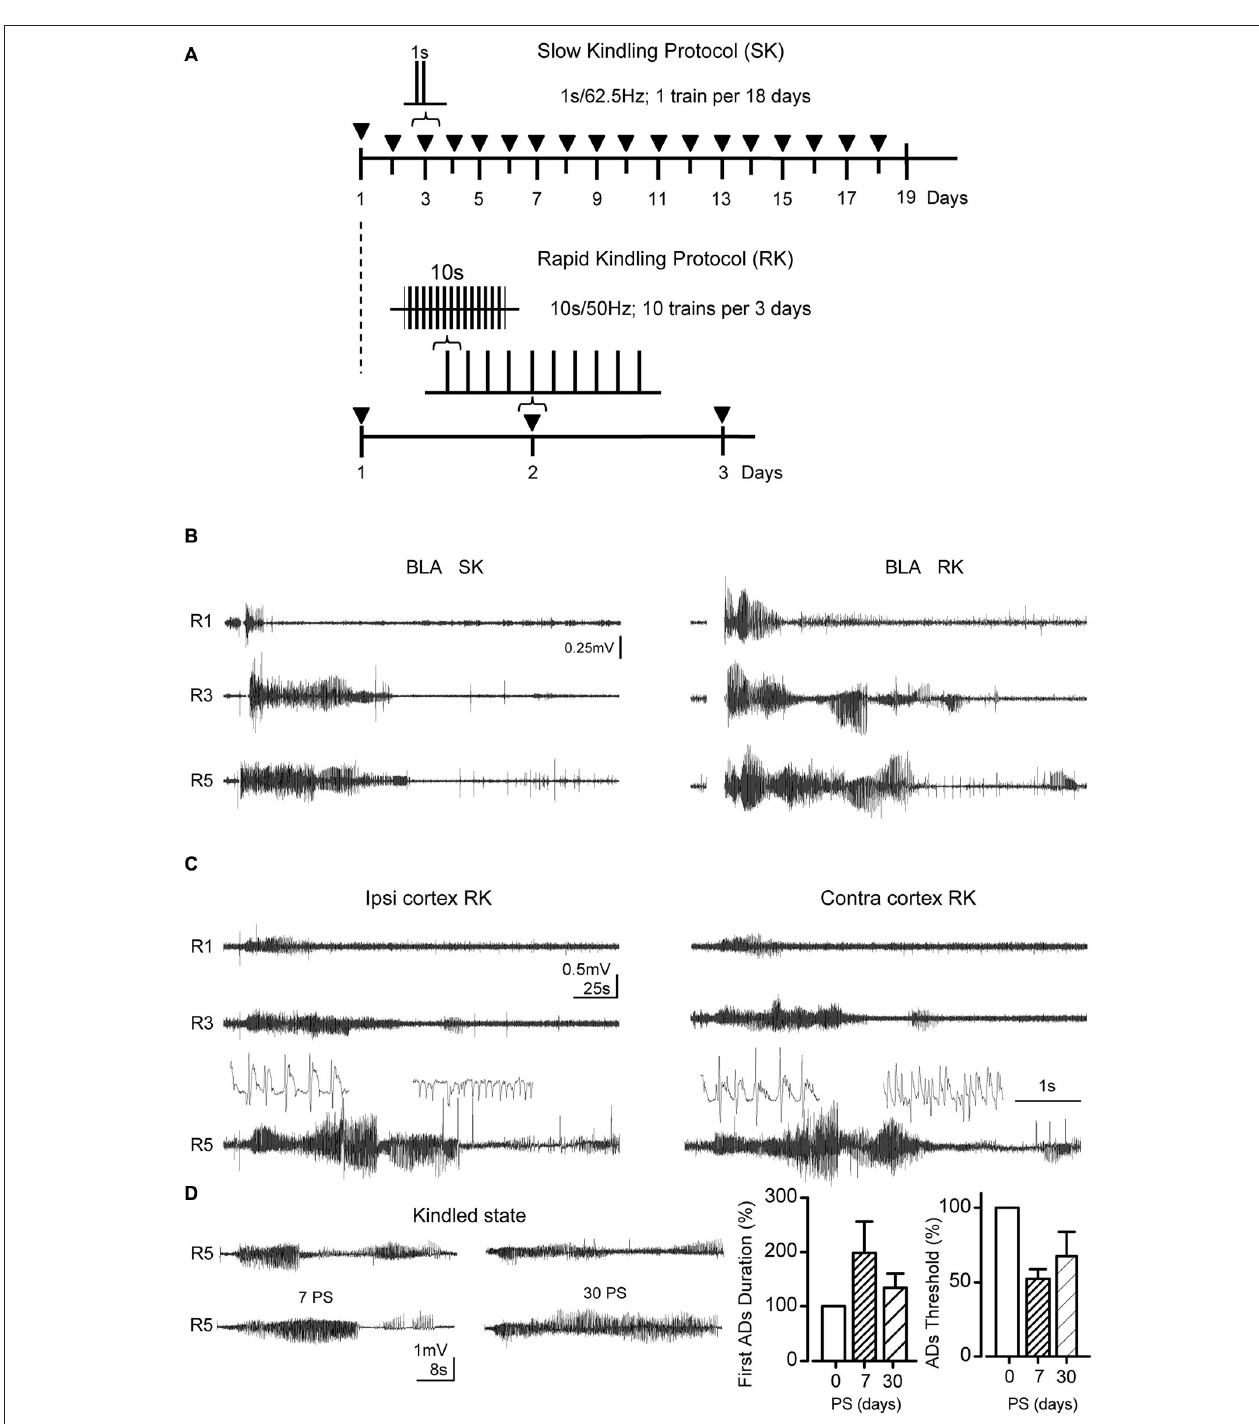
and BLA evoked by RK protocol in B. The insets show spike-waves and heterogeneous spikes from R5 ADs (below) in an expanded scale. (D) Representative ADs recordings corresponding to R5 at 0, 7 and 30 post-stimulation days (0, 7 and 30 PS) after RK protocol completion. Left, bar charts represent the percent change of the R5 first-AD duration with respect to 0 PS ADs (during protocol) at the indicated days. Right, percentage change of ADs thresholds at 0, 7 and 30 PS ( n = 6 at 0, n = 3 at 7 and 30 PS, non-overlapping